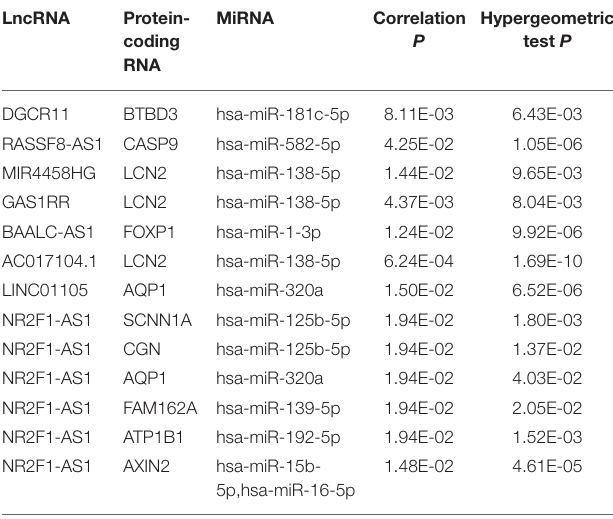
Hypergeometric P test